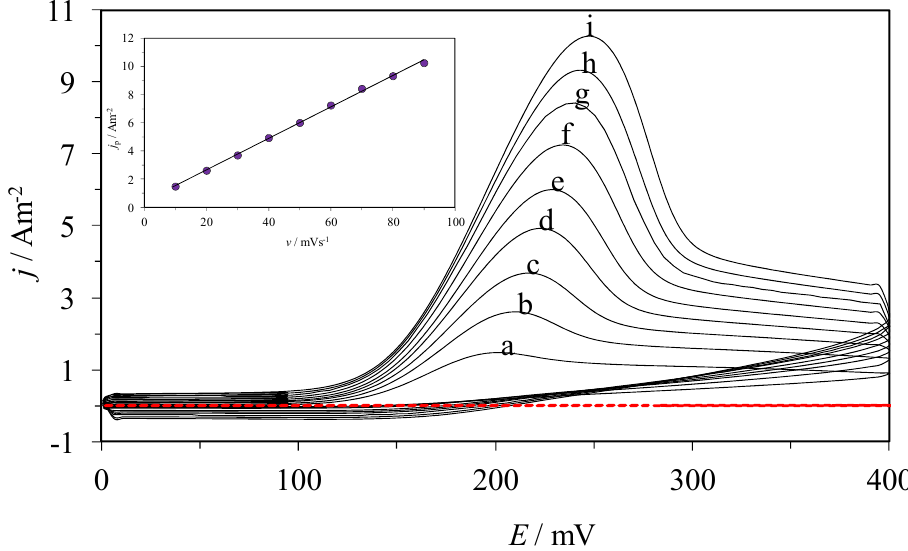
Figure 4. ( a ) CVs obtained from the system CPE/poly- β -CD/1 mM AA, 0.1 M NaCl, at pH 3.0, at different potential scan rates, as indicated: (a) 10, (b) 20, (c) 30, (d) 40, (e)